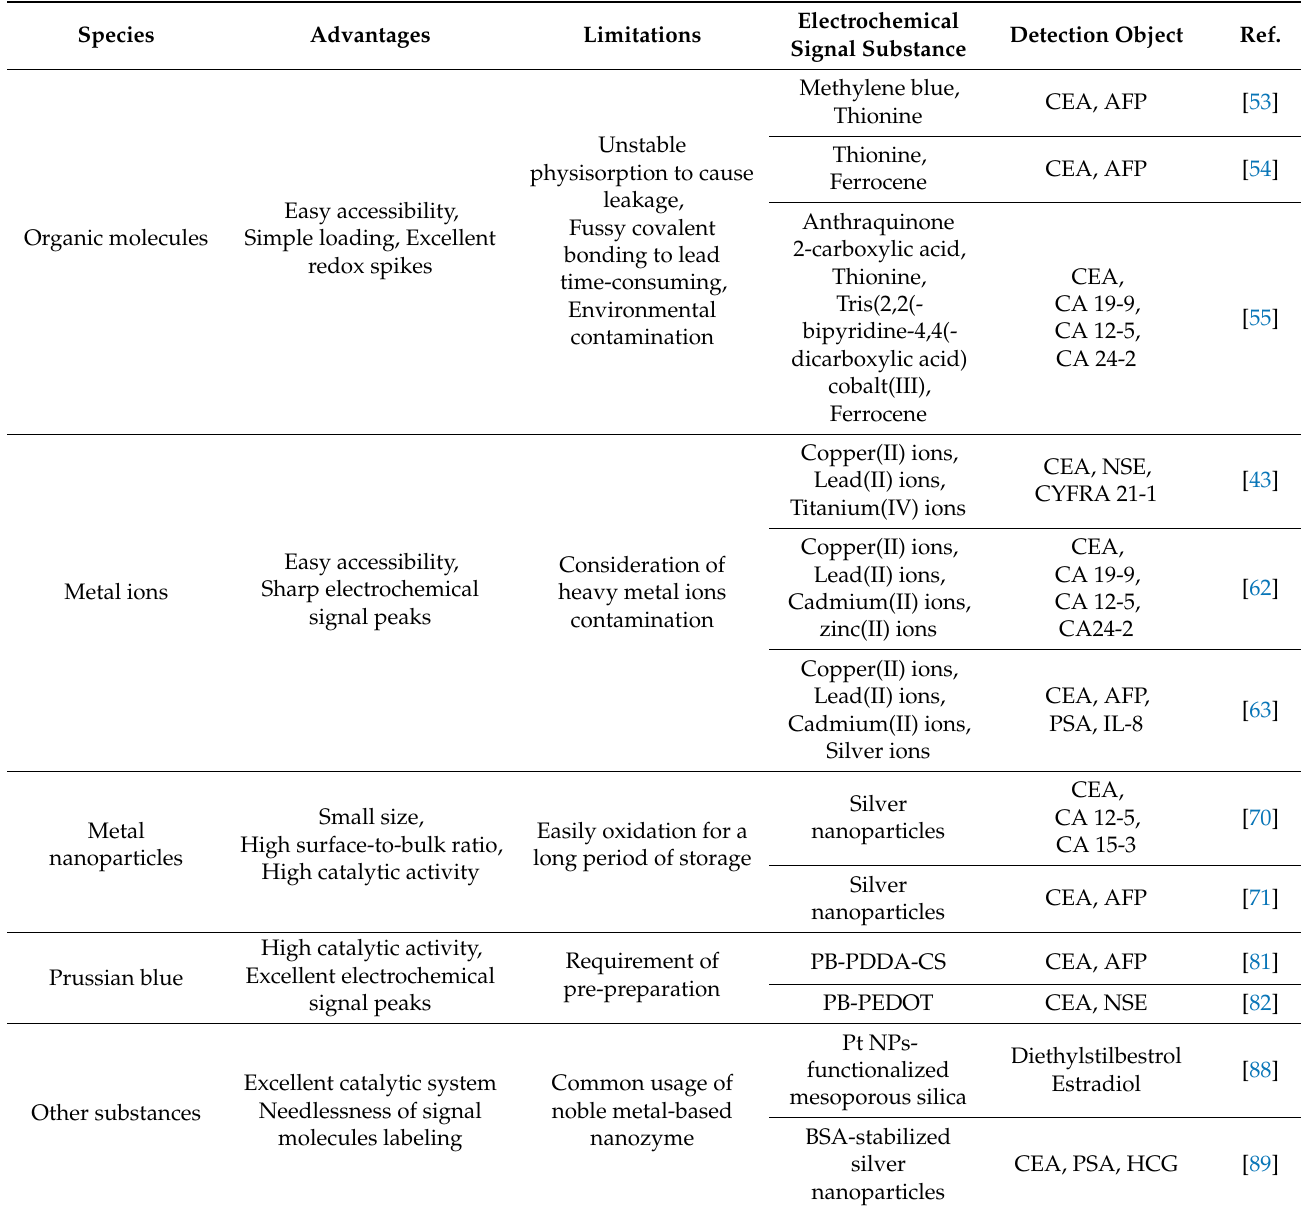
Table 1. Summary of the advantages and limitations for various electrochemical signal substances and some reported